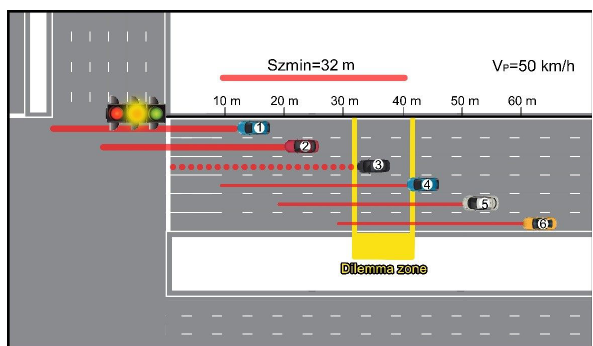
Figure 2: Diagram of access to the stop line at the intersection after the yellow signal is displayed for different car positions in front of the stop line,